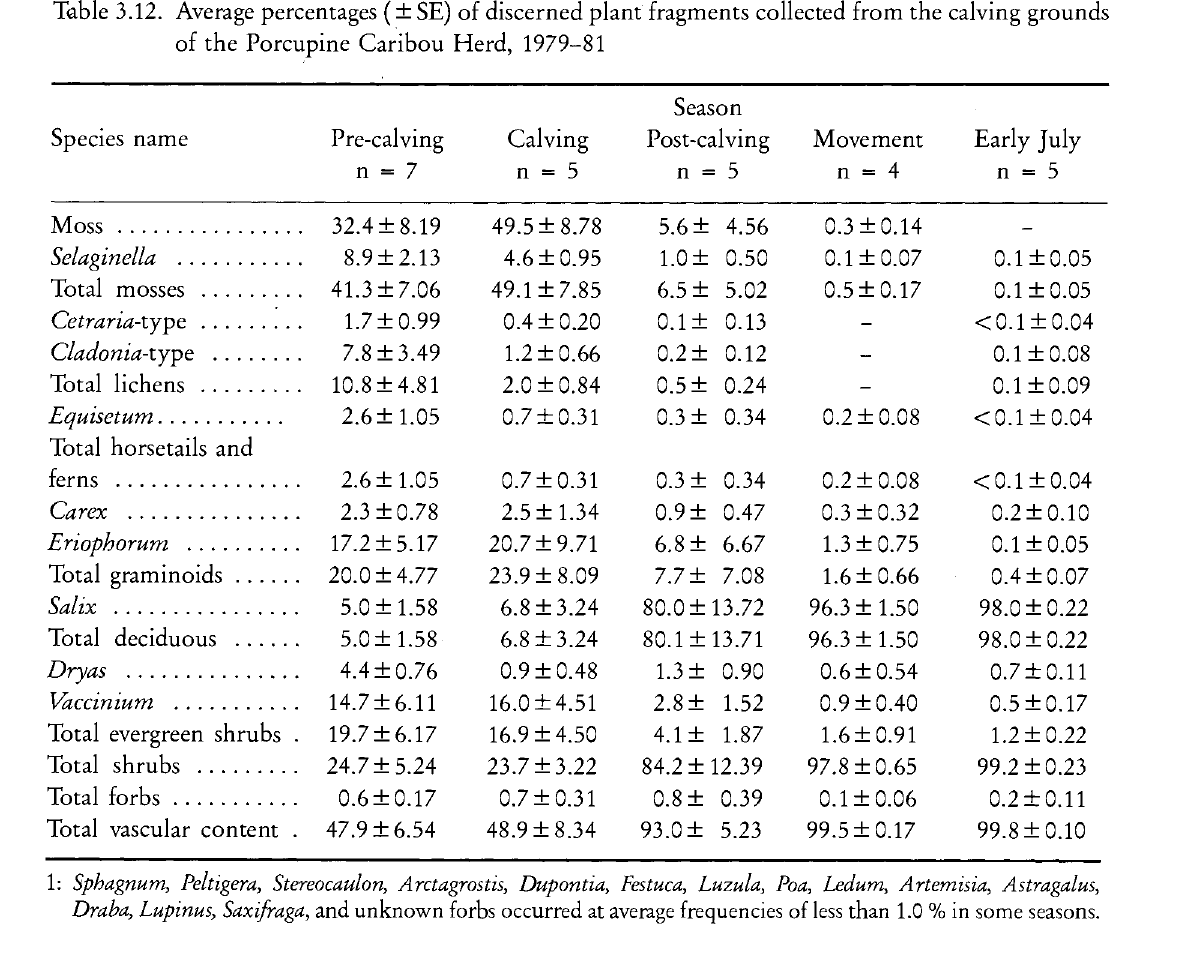
Table 3.12. Average percentages (± SE) of discerned plant fragments collected from the calving grounds of the Porcupine Caribou Herd,